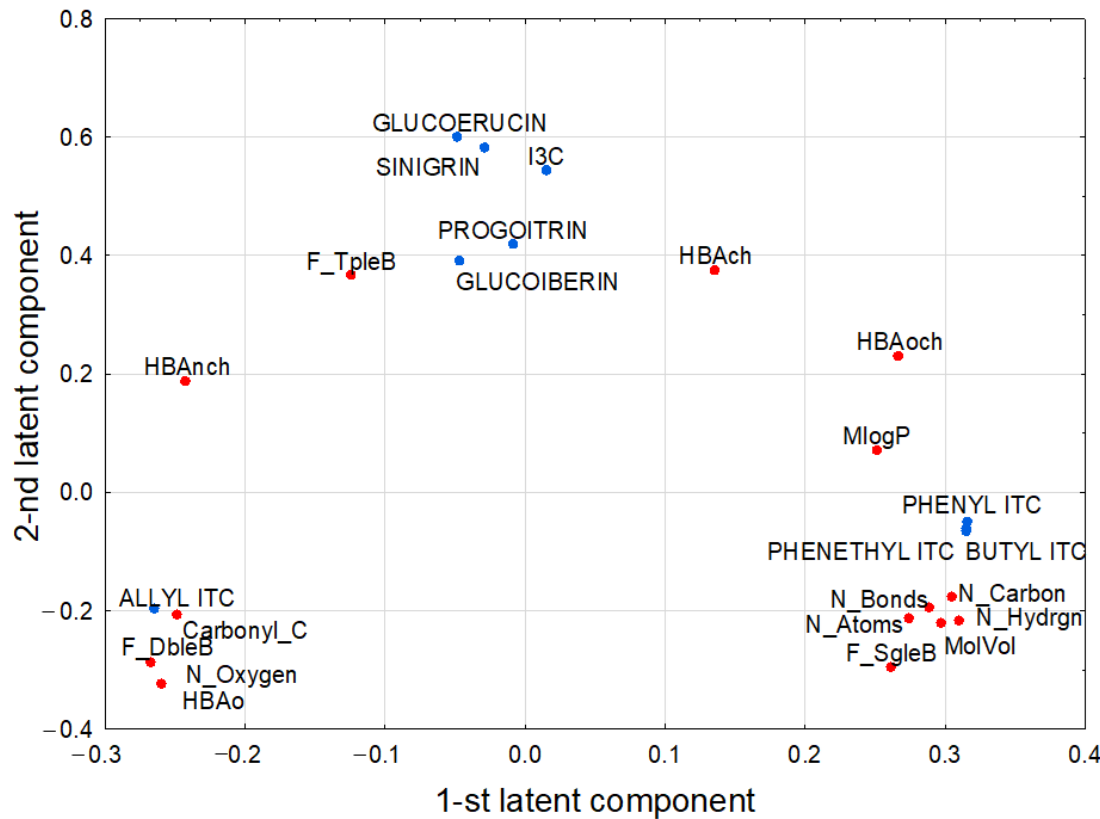
Figure 1. Loadings of first and second latent components in the PLS model. The model correlated the predictive parameters (MlogP, MolVol, N_Atoms, N_Carbon, N_Hydrgn, N_Oxygen, N_Bonds, F_SgleB, F_DbleB, F_TpleB, Carbonyl_C=O, HBAo, HBAch, BAoch, HBAnch) and response ones (allyl isothiocyanate (ALLYL ITC), butyl isothiocyanate (BUTYL ITC), glucoerucin, glucoiberin, indol-3-carbinol (I3C), phenyl isothiocyanate (PHENYL ITC), phenethyl isothiocyanate (PHENYLETHYL ITC), progoitrin, and sinigrin).